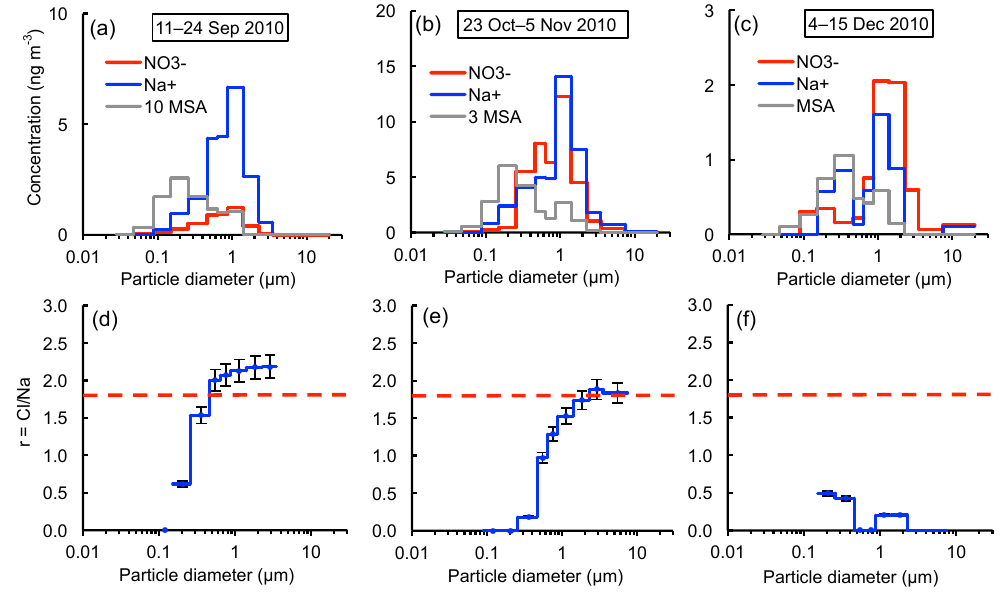
Figure 6. (a–c) Size-segregated aerosol composition (nitrate, sodium and MSA) from September to December 2010 at Concordia. In (a) and (b) , MSA levels were multiplied by a factor of 10 and 3, respectively. From (a) to (c) , the levels of HNO 3 simultaneously sampled on denuder tubes were enhanced from 3.5 ± 1 to 40 ± 7ngm − 3 and 80 ± 1ngm − 3 (see Sect. 3.1). From (d) to (f) , the corresponding r values as function of the aerosol